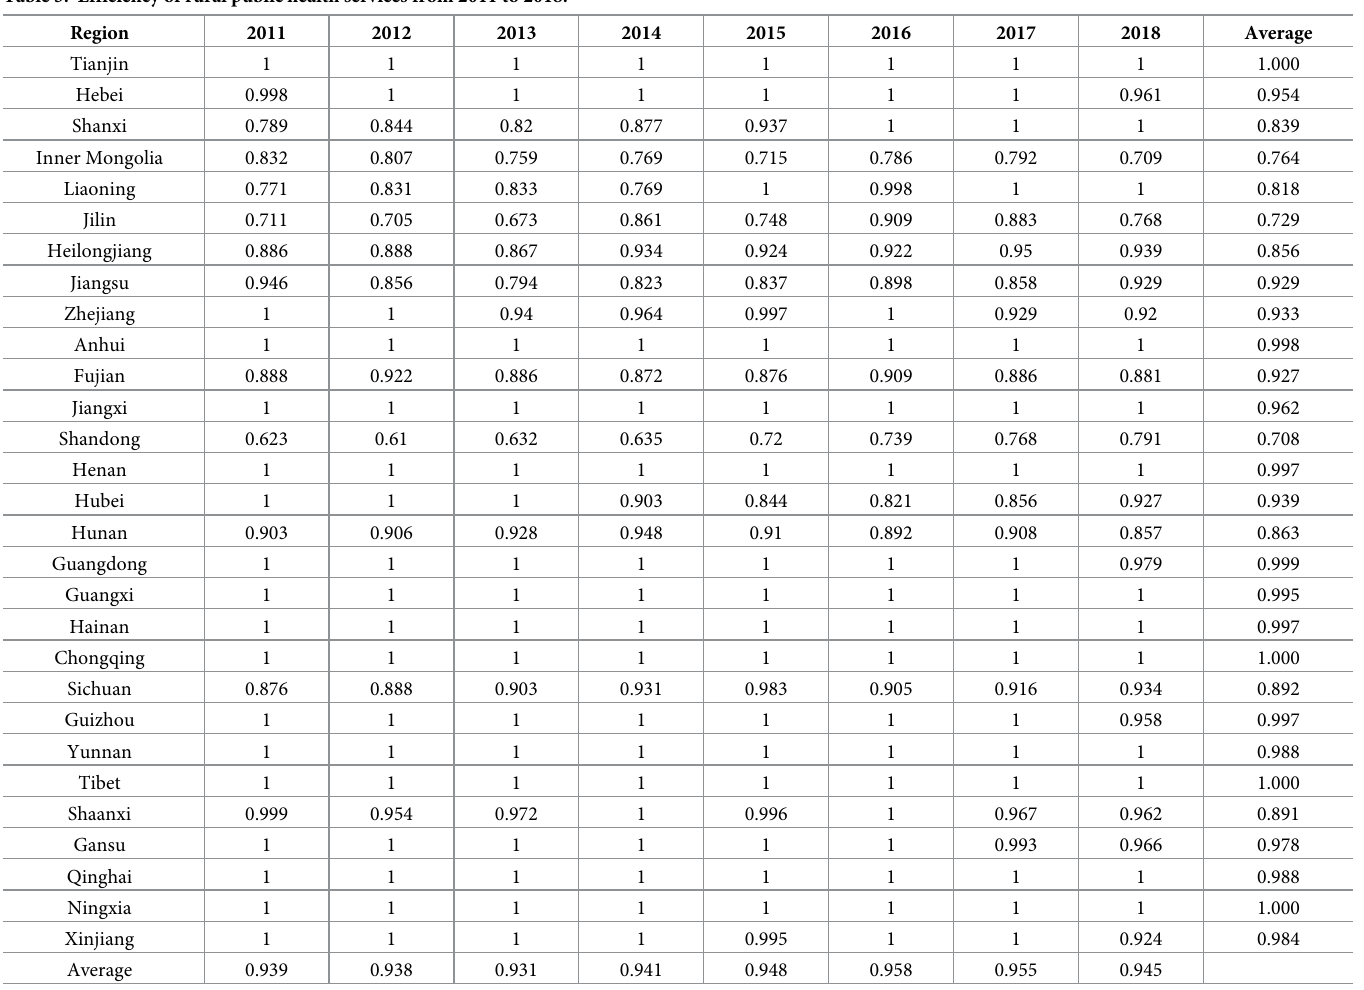
Table 3. Efficiency of rural public health services from 2011 to